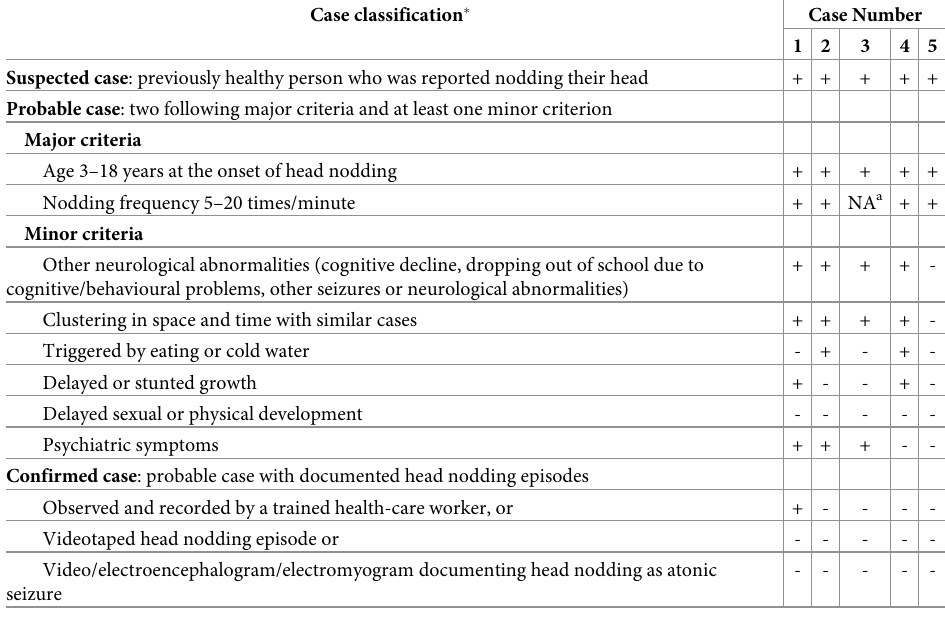
Table 2. Case classification of Nodding Syndrome in Central African Republic, 2019.